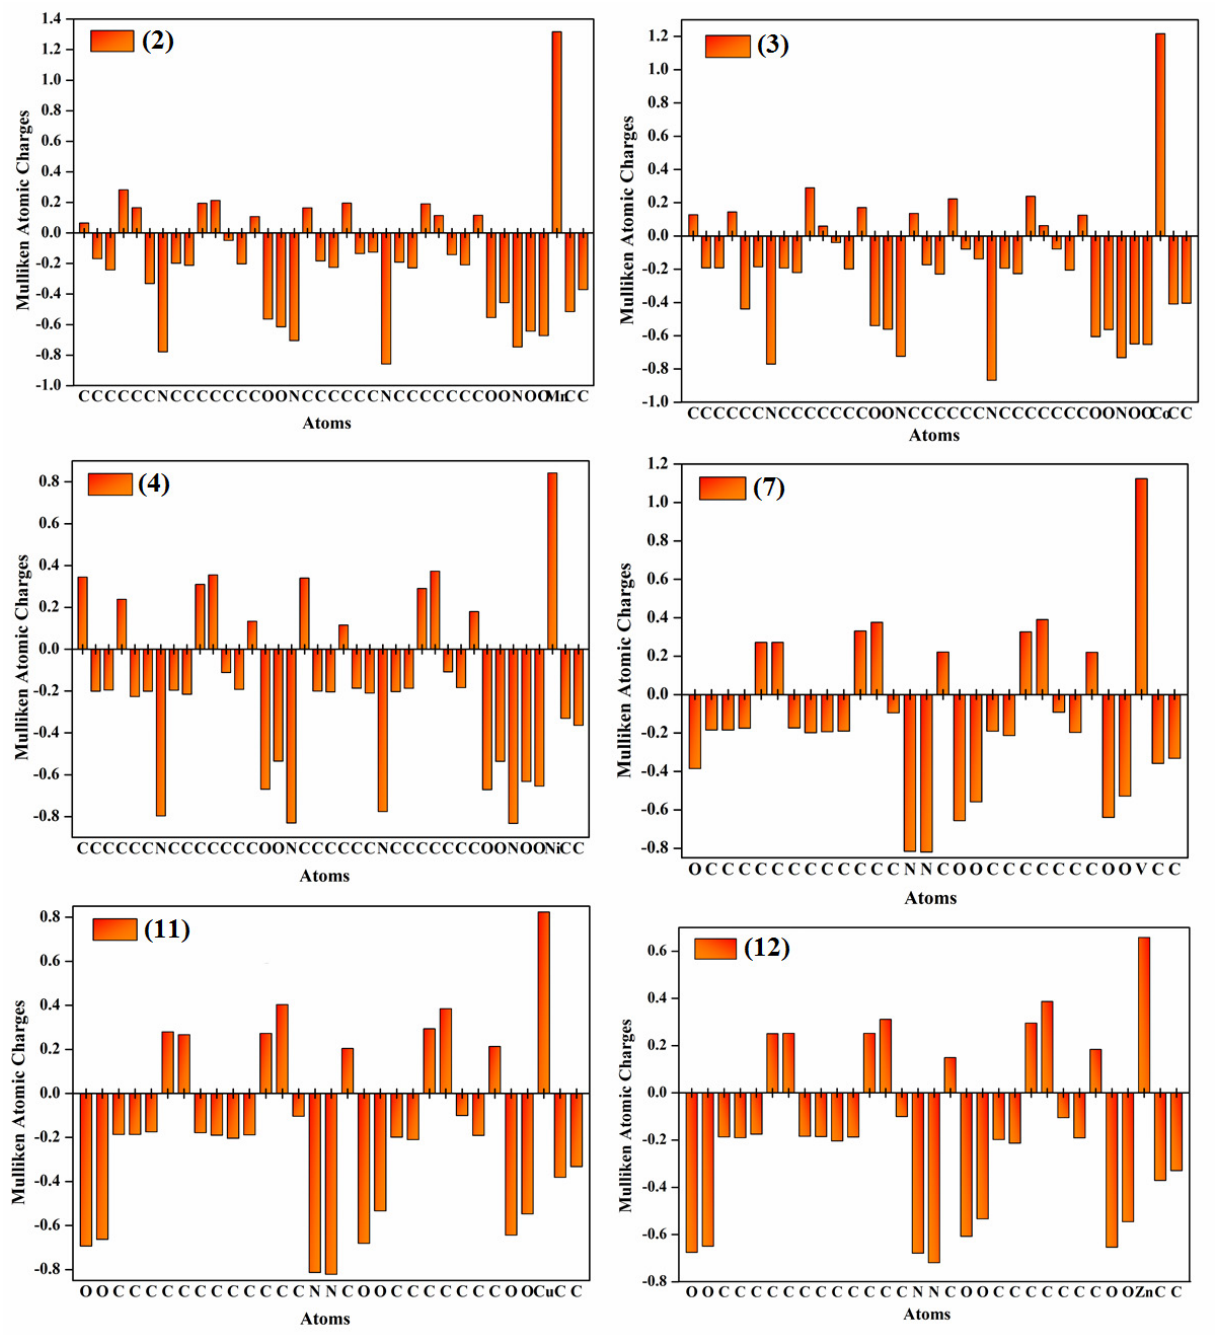
Figure 7. Histogram for Mulliken atomic charges of studied metal